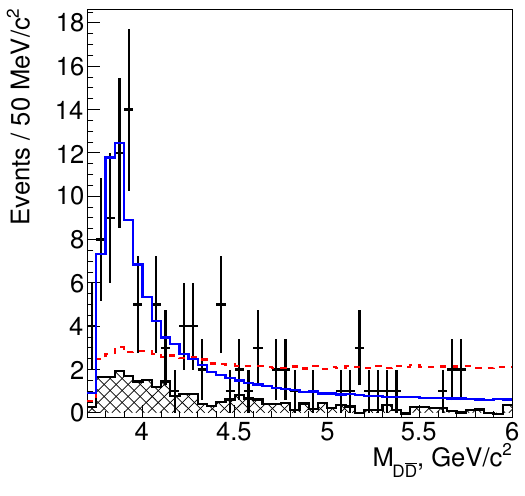
Figure 4. Projections of the e + e − → J /ψ D ( ∗ ) ¯ D ( ∗ ) fit results onto M D ¯ D . The points with error bars are the data, the hatched histogram is the background, the blue solid line is the fit with the X ∗ resonance ( J PC = 0 ++ ), and the red dashed line is the fit with nonresonant amplitude only. Figure from reference [4].